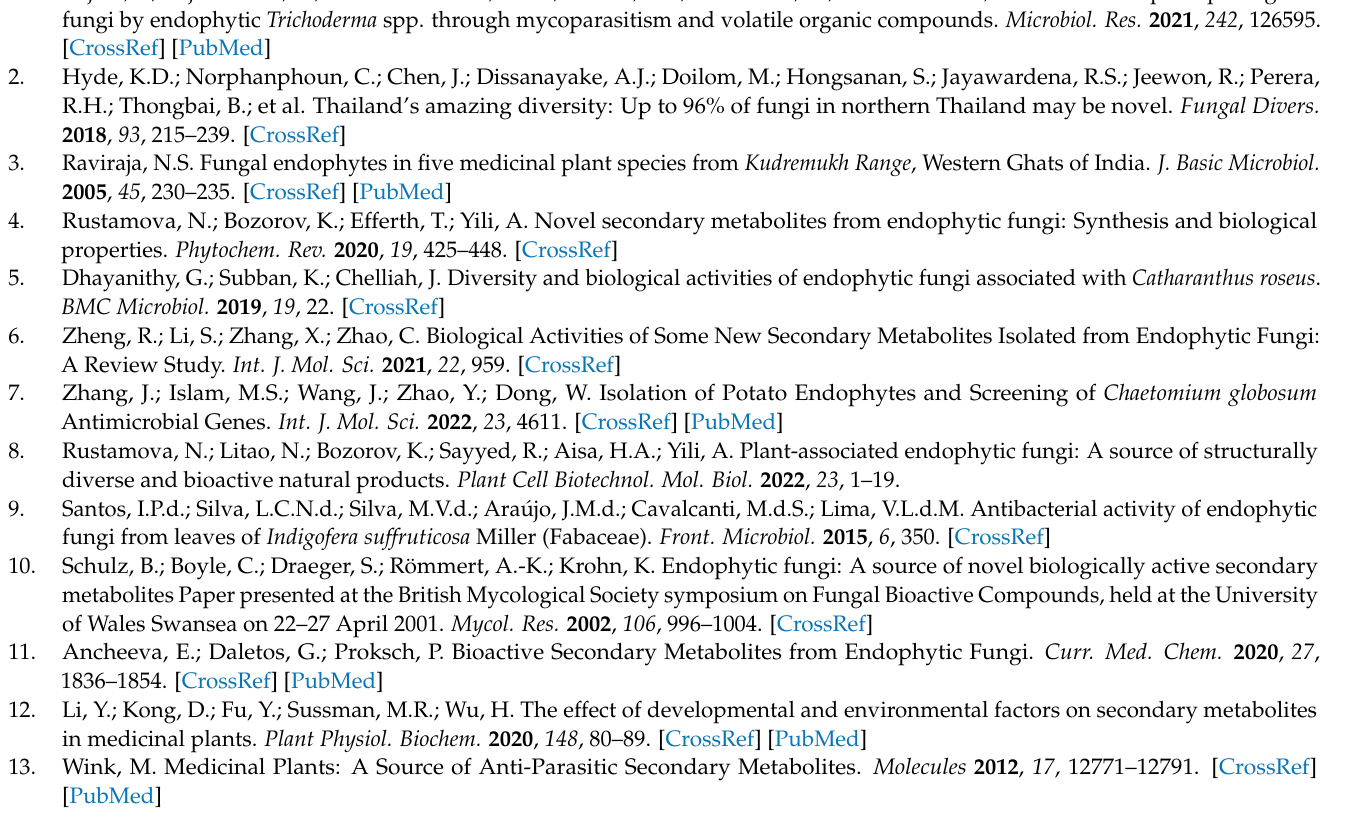
Figure S12: Volatile chemical composition dichloromethane extract of the endophyic fungus of O. sene- galensis NR-03 growth on MEM medium; Figure S13: Volatile chemical composition dichloromethane extract of the endophyic fungus of O. senegalensis NR-03 growth on PBG medium; Figure S14: Volatile chemical composition dichloromethane extract of the endophyic fungus of O. senegalensis NR-03 growth on CDM medium; Figure S15: Volatile chemical composition dichloromethane extract of the endophyic fungus of O. senegalensis NR-03 growth on PDB medium; Figure S16: Chemical structure of same main volatile chemical compounds of dichloromethane fraction of O. senegalensis